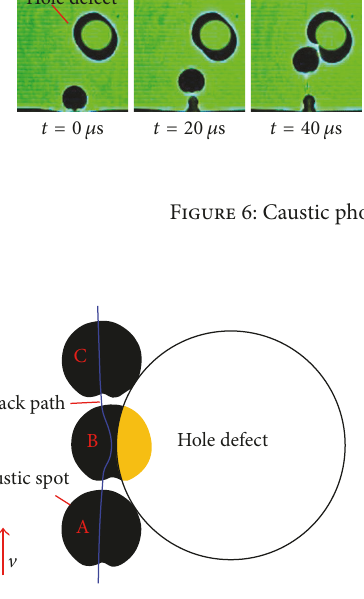
Figure 7: Diagram of running crack path near to the defect.